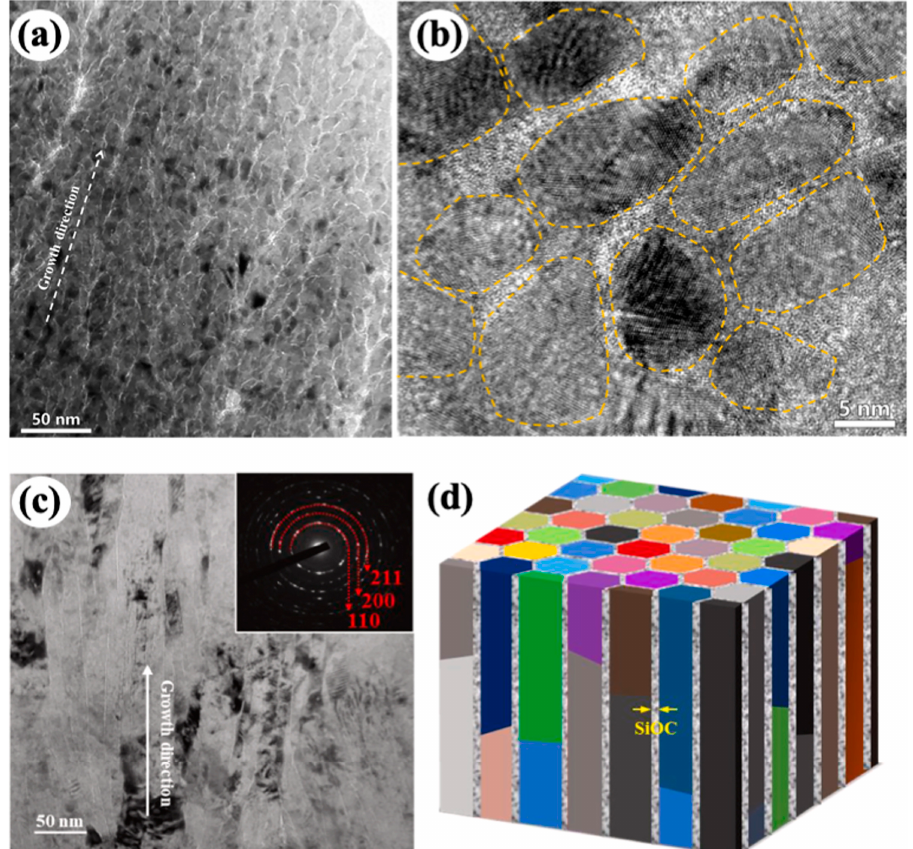
Figure 3. ( a ) TEM image of the as-deposited Ni(75 at.%)-SiOC core–shell nanocomposite and ( b ) HRTEM image showing nanocrystalline Ni and amorphous SiOC GBs [53]. ( c ) TEM image of the as- deposited Fe(80 at.%)-SiOC core–shell nanocolumnars and ( d ) the schematic diagram of the core– shell nanocolumnar structures [72].